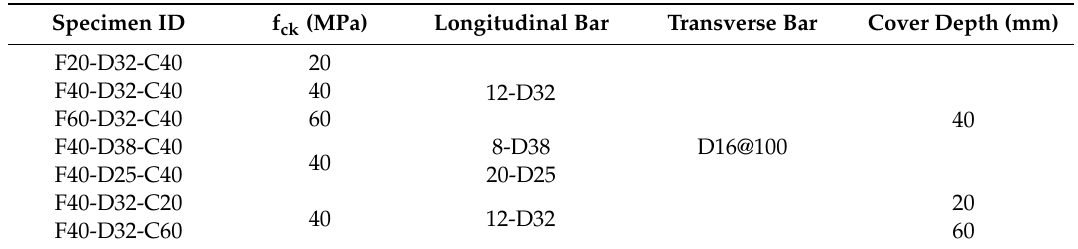
Table 3. Experimental design.